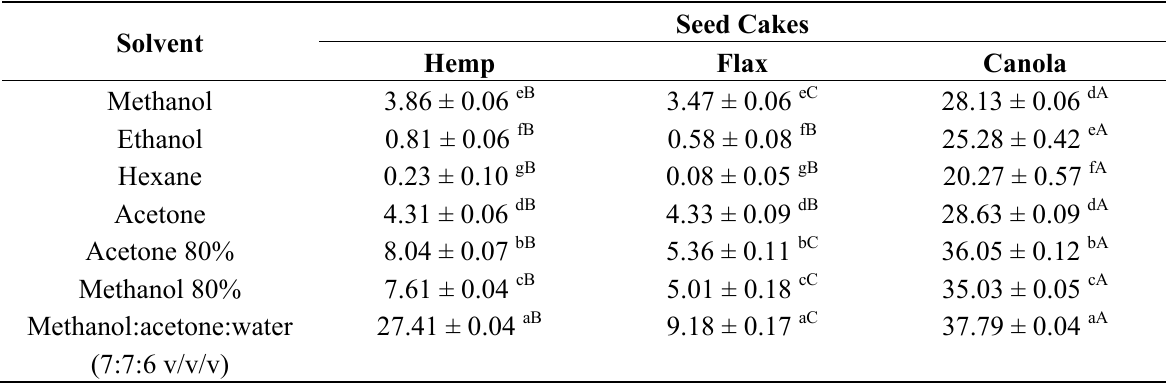
Table 2. Total flavonoids (mg LUE/100 g fresh